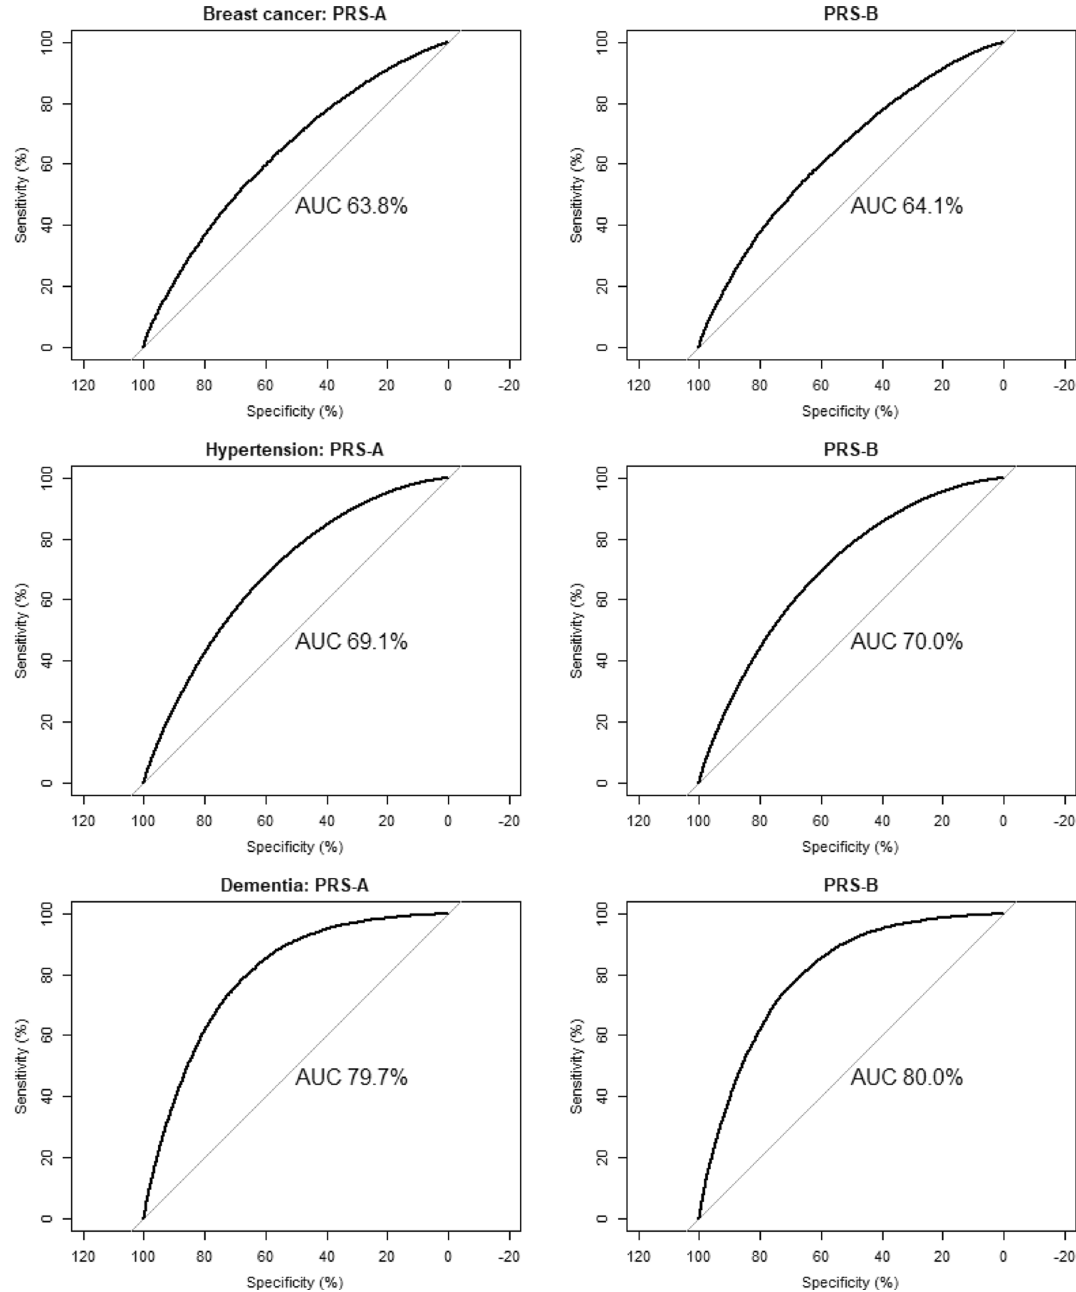
Figure 1. ROC plots obtained from predictions from multivariable logistic regression of age, sex, continuous PRS, genotyping array and first 5 PCs against disease